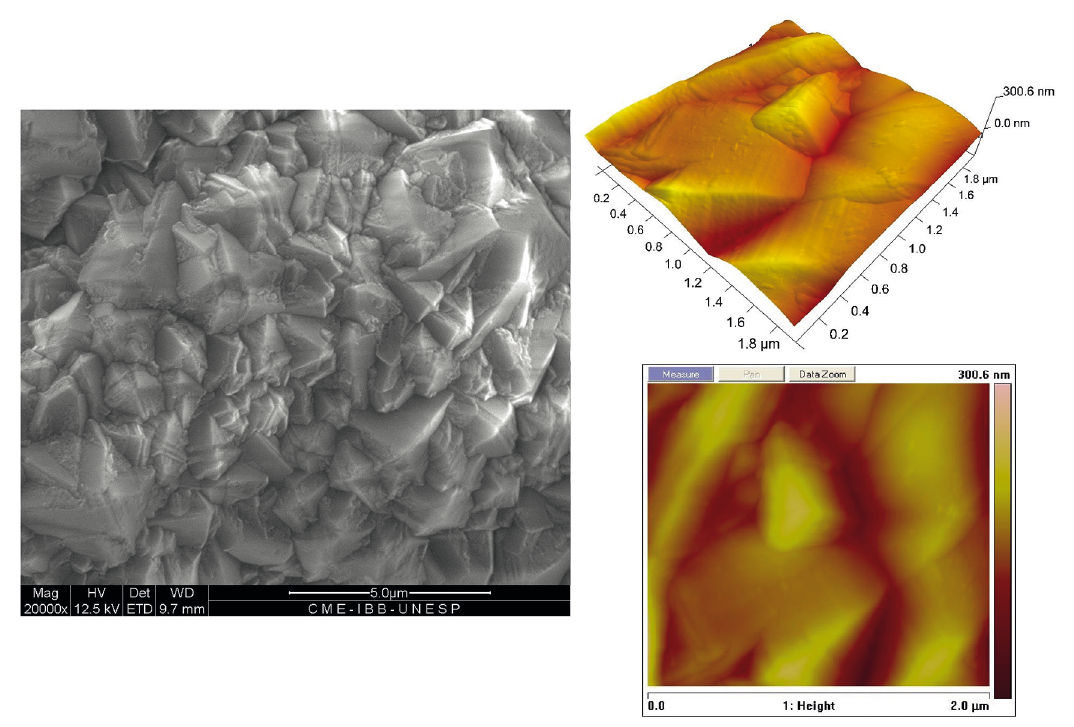
Figure 4. Morphology of the film obtained by atomic force microscopy. The scanning is 1.8 X 1.8 X 0.3 µm. The face of the diamond has a preferred plan with a seemingly tetrahedral shape.